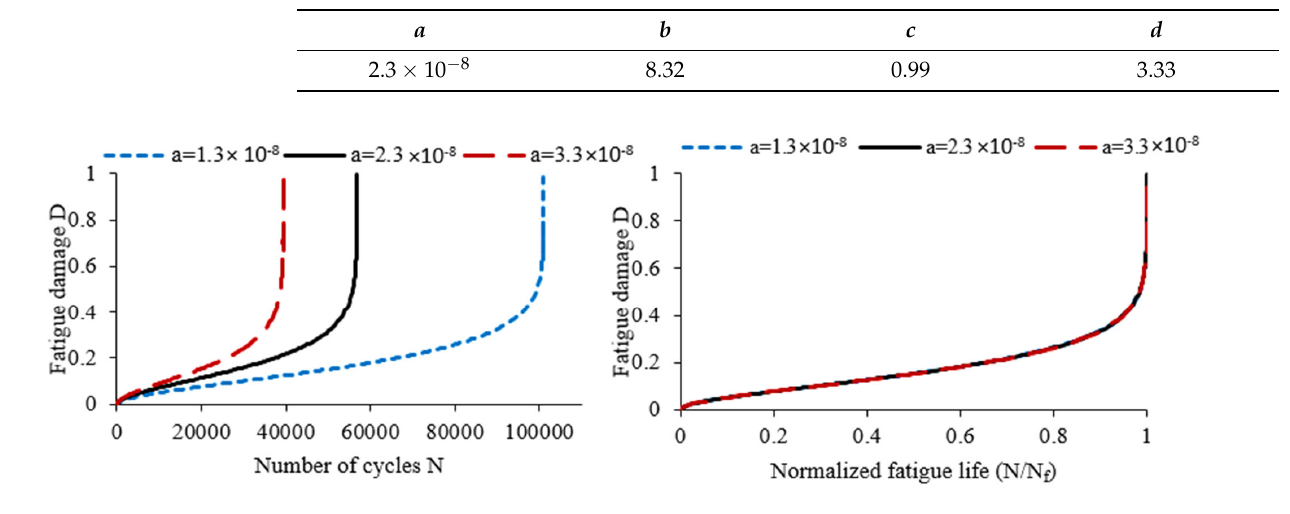
However, increasing its value decreases the number of cycles needed to reach failure. Figure 7. In fl uence of parameter ( ) a on damage evolution. Figure 7. Influence of parameter ( a ) on damage evolution.